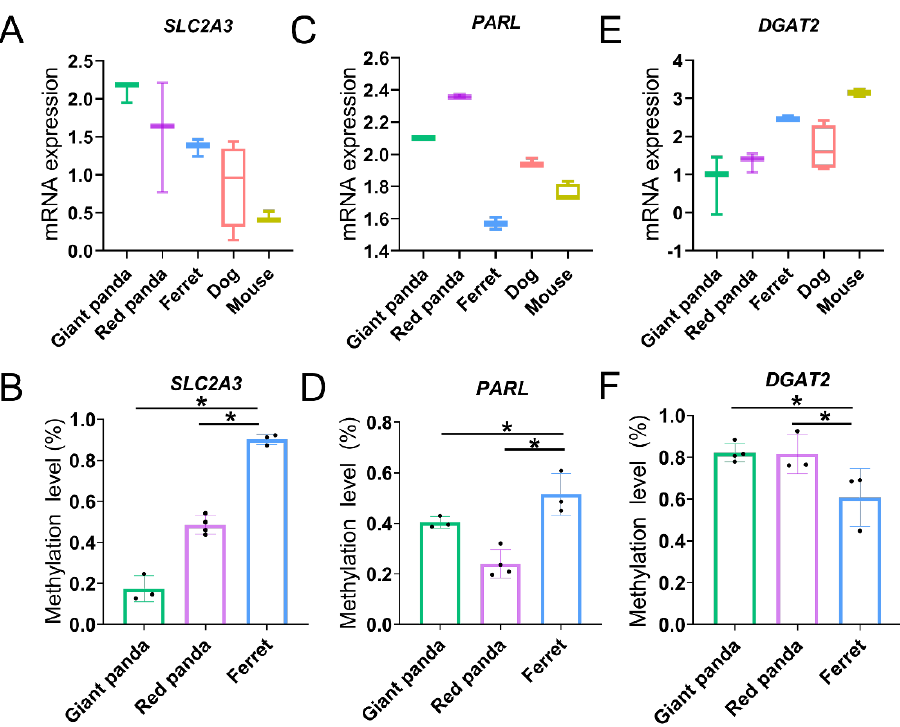
Figure 8. The mRNA expression ( A , C , E ) and promoter methylation ( B , D , F ) levels of DEGs in stom- ach and small intestine samples. * indicates Padj < 0.05. and small intestine samples. * indicates Padj <